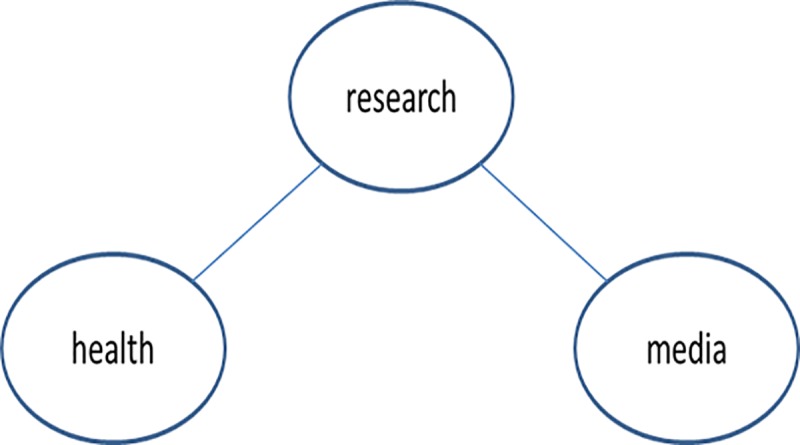
Example network.